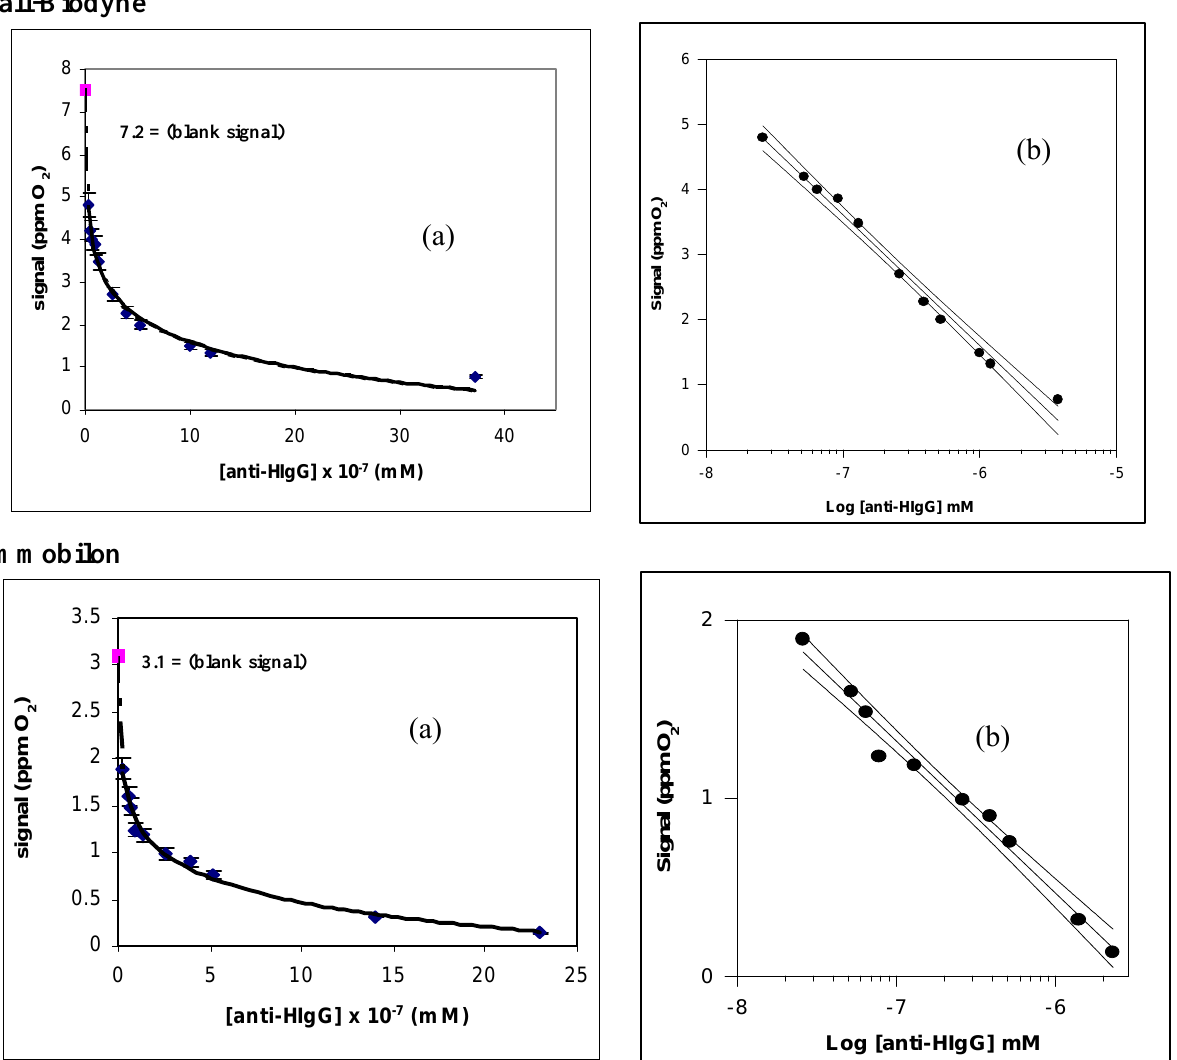
Table 1. Analytical characterization of new immunosensor method for anti-HIgG determination, using two different membranes for antibody immobilization.